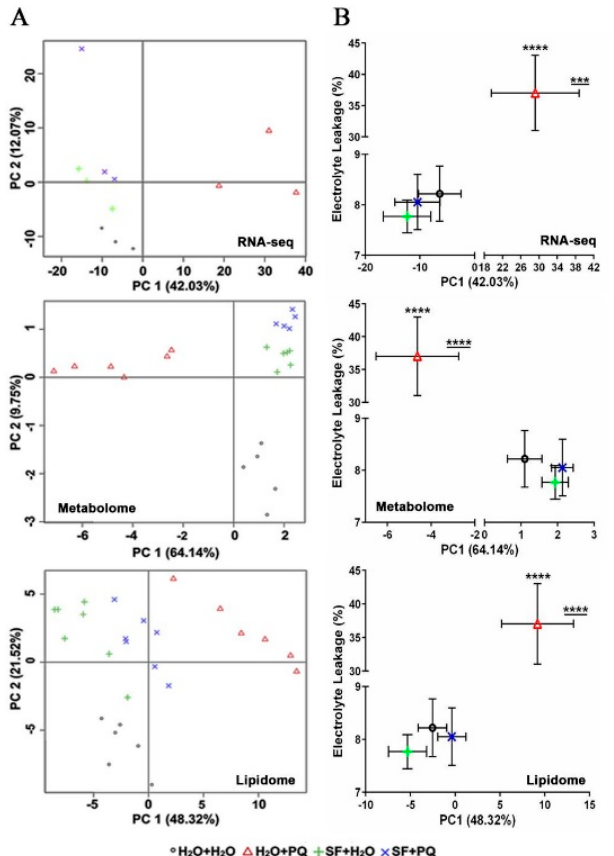
Figure 8. Principle component analysis (PCA) of omics data. ( A ) PCA of RNA-seq, metabolome, and lipidome data. Plotted are three biological replicates per condition for RNA-seq, five to six biological replicates per condition for metabolome, and seven biological replicates per condition for lipidome. Samples: unprimed and unstressed (H 2 O + H 2 O), PQ-stressed (H 2 O + PQ), SF-primed but unstressed (SF + H 2 O), and SF-primed and stressed (SF + PQ). ( B ) Scatter plot of PC1 values versus mean electrolyte leakage (%). Mean PC1 values were compared among groups using one-way ANOVA followed by Tukey’s multiple comparisons test to correct for multiple testing. For both, PC1 and electrolyte leakage, a significant difference was observed between the H 2 O + PQ group (oxidatively stressed) and each of the three remaining groups. For PC1, the adjusted p -values for all three pairwise comparisons were p ≤ 0.0004 (***), < 0.0001 (****), and < 0.0001 (****) for transcriptome, metabolome, and lipidome, respectively (underlined in the graph; see Figure S2 for comparison of PC1 values by one-way ANOVA).). Horizontal error bars denote the standard deviation (SD) of PC1 values. Vertical error bars indicate the SD of electrolyte leakage. Full data are given in Supplementary Materials Data S1 and